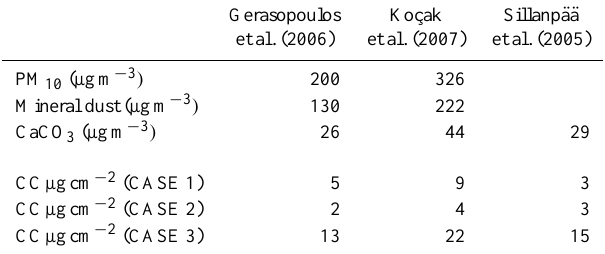
Table 1. Expected atmospheric CC concentrations during dust events based on previous published